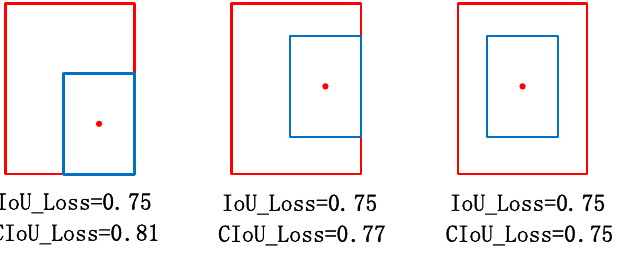
Figure 11. Description diagram of the relative position between the prediction box and the real box.